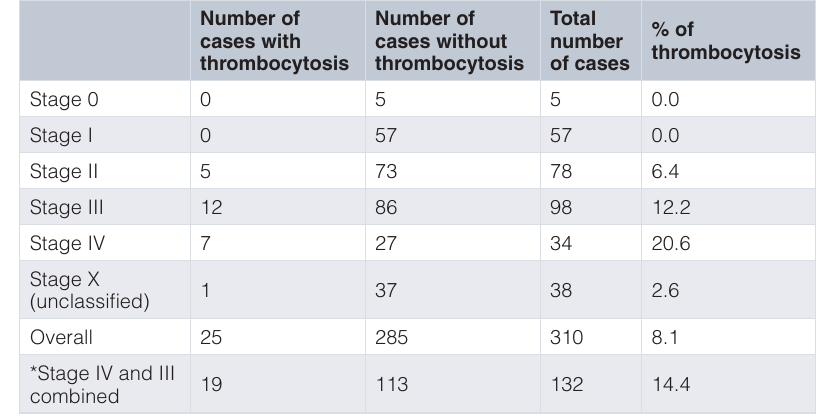
Table 2. Incidence of thrombocytosis in each stage of colorectal